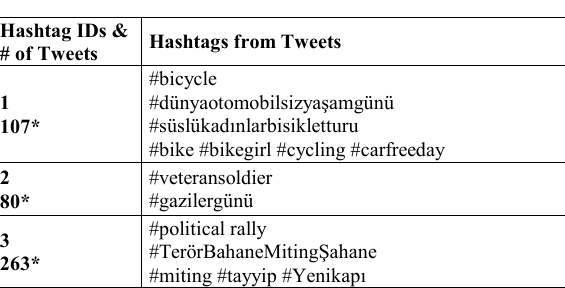
Figure 5. Categorized Hashtag Distribution